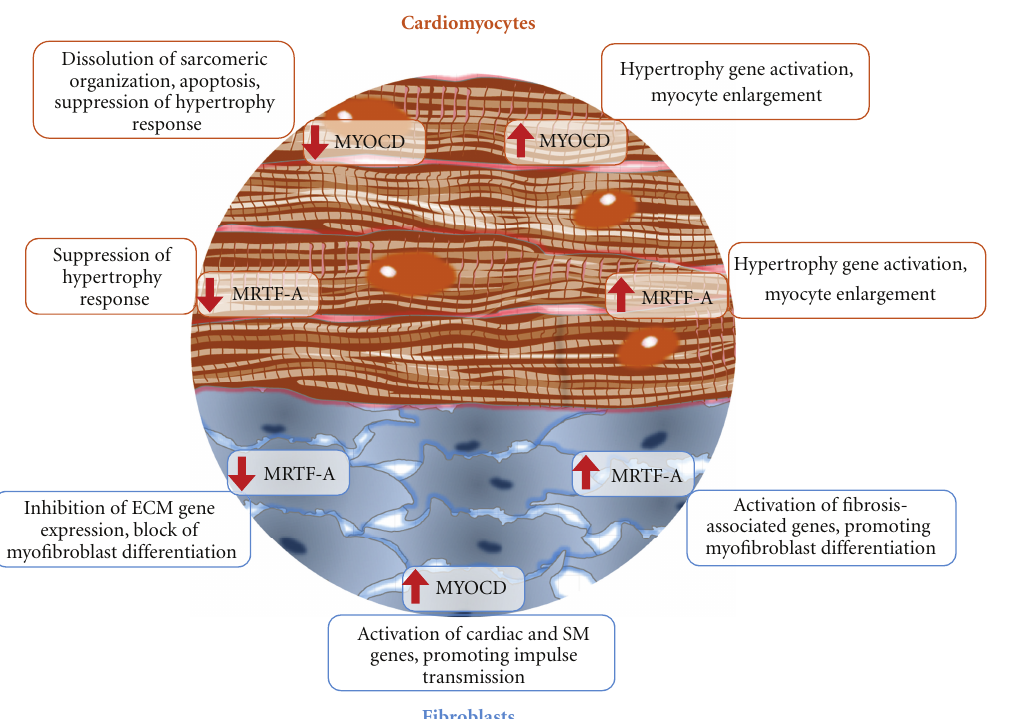
Figure 2: Dissecting the cell-autonomous roles of myocardin and MRTF-A in adult ventricular myocardium. Red arrows indicate up- or downregulation. In cardiomyocytes, forced expression of either Myocd or Mrtf-A induces hypertrophic gene expression and myocyte enlargement, whereas inhibition of any of these factors markedly attenuates hypertrophic responses. Although both factors display prohypertrophic activities, MYOCD, but not MRTF-A, is absolutely required for myocyte structural integrity and survival [43]. In cardiac fibroblasts, forced expression of Mrtf-A activates profibrosis gene expression and myofibroblast di ff erentiation, whereas a loss of functional Mrtf-A leads to opposite e ff ects. Forced Myocd expression stimulates both SM (including markers of myofibroblast di ff erentiation) and cardiac genes (including cardiac ion channels and connexins) in ventricular